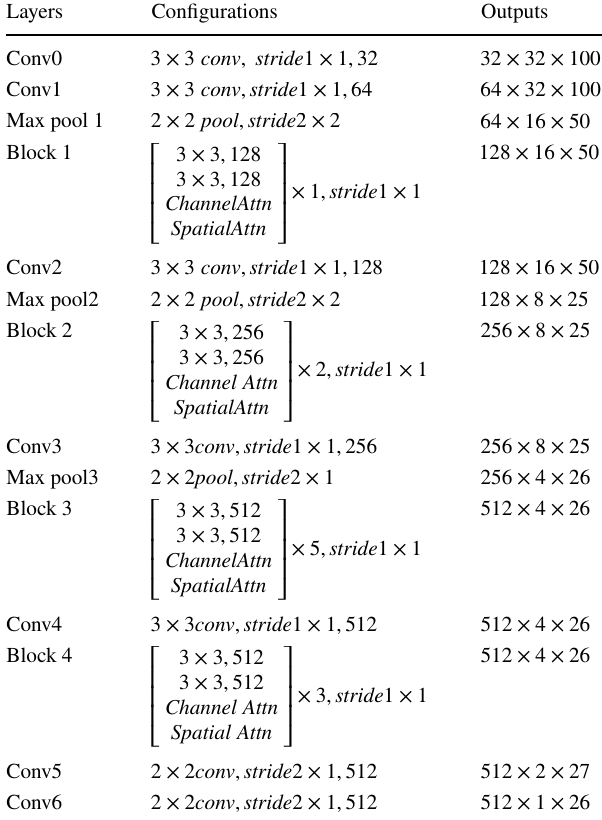
Fig. 4 Residual block combined with CBAM unit